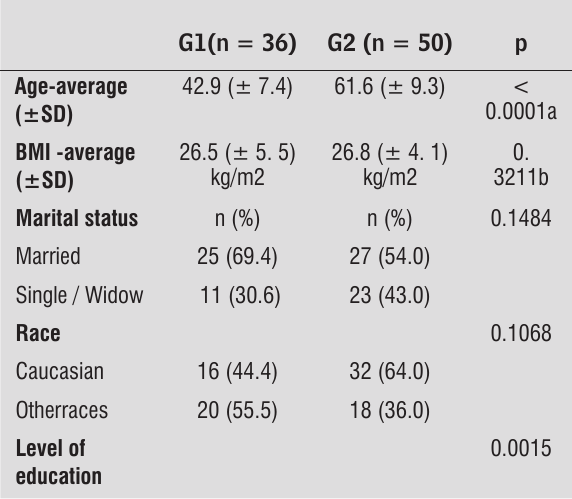
Table 1 - Sociodemographic, clinical and obstetrical data background of (G1) women on